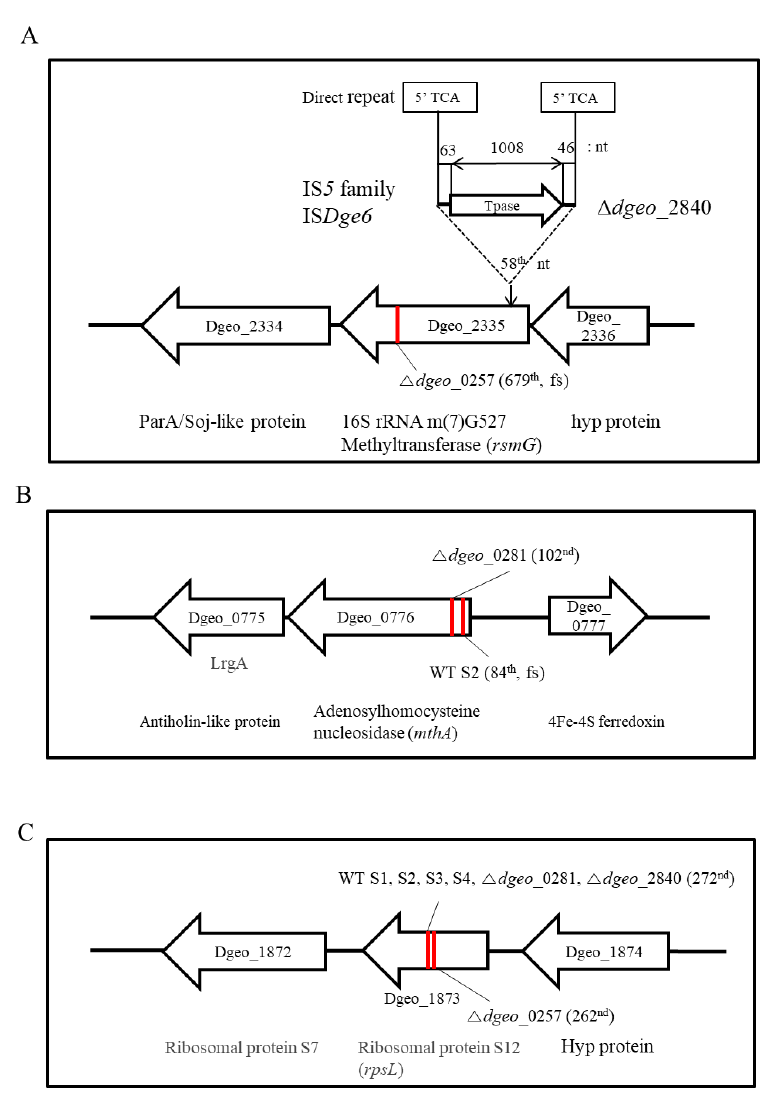
Figure 4. Detection of insertion sequence (IS) transposition and loci of point mutations in the Sm resistance-related genes rsmG ( dgeo _2335) ( A ), mthA ( dgeo _0776) ( B ), and rpsL ( dgeo _1873) ( C ). The IS Dge6 element of the IS 5 family was integrated at the 58th nucleotide of rsmG ( A ). Streptomycin resistance mutants from wild-type, Δ dgeo _0257, Δ dgeo _0281, and Δ dgeo _2840 mutant strains have frameshift or point mutations in three Sm resistance-related genes. All mutations are also summa- rized in Table 1.